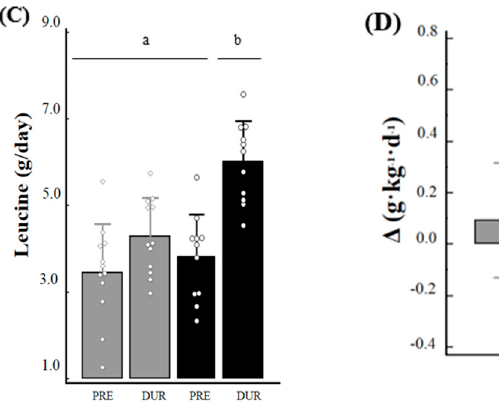
Figure 3. Daily intake of protein ( A ), BCAA ( B ) and leucine ( C ) at pre and during the study and respective deltas ( D ). Notes: DUR: during; Δ : delta values; BCAA: branched-chain amino acid. Generalized Estimating Equation (GEE) with sequential Sidak post hoc was performed to evaluate the intake between groups and moments; independent t -test was performed to evaluate the difference between deltas; *: different ( p < 0.05) from delta NP. Different letters (a, b) mean p < 0.05. Circle sign is the value of each individual of the study.